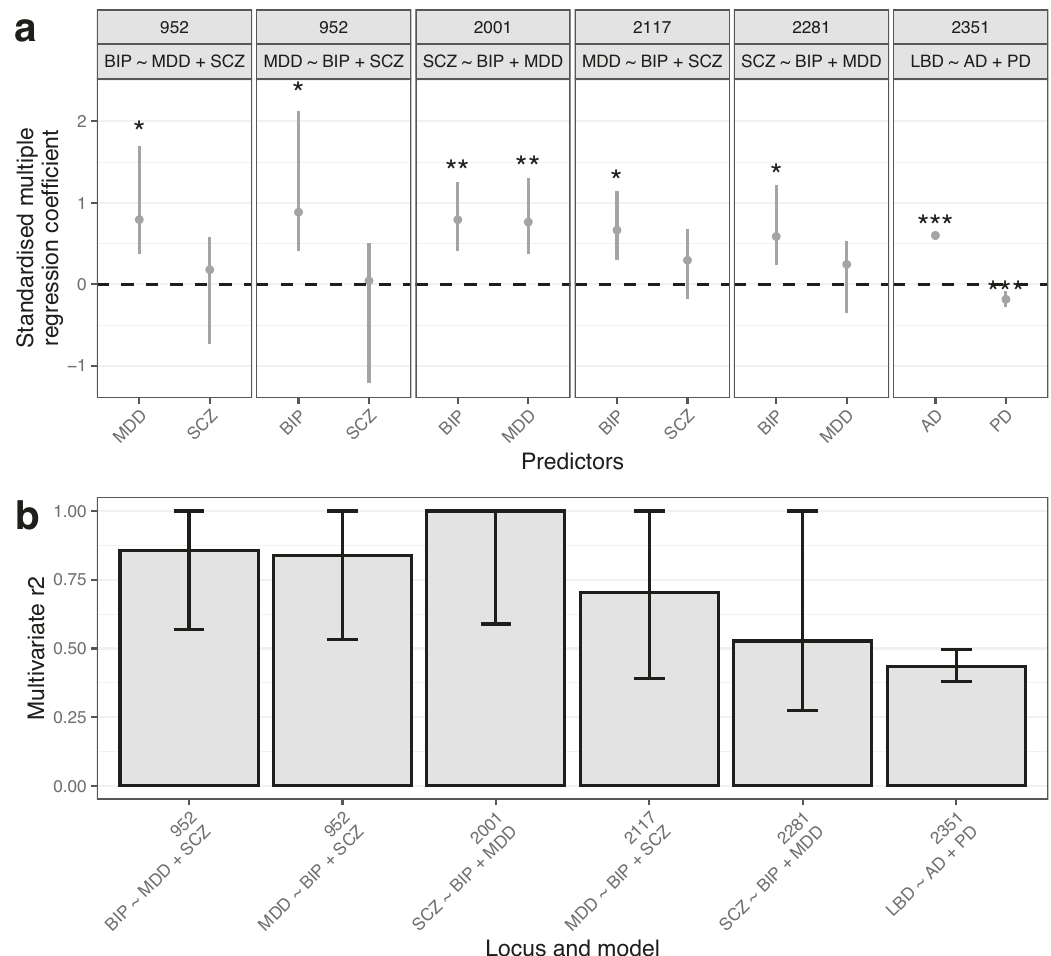
Fig. 3 Multiple regression across LD blocks with multiple trait pair correlations. For both plots, only those multiple regression models with at least one signi fi cant predictor ( p < 0.05) are shown (for models where all predictors were non-signi fi cant, see Supplementary Fig. 4). a Plots of standardised coef fi cients for each predictor in multiple regression models across each LD block, with whiskers spanning the 95% con fi dence interval for the coef fi cients. Panels are labelled by the LD block identi fi er and the regression model. b Multivariate r 2 for each LD block and model, where multivariate r 2 represents the proportion of variance in genetic signal for the outcome trait explained by all predictor traits simultaneously. Whiskers span the 95% con fi dence interval for the r 2 . *** p < 0.001; ** p < 0.01; * p < 0.05. Coordinates for LD blocks (in the format chromosome:start-end, GRCh37): 952, chr6:27,261,036-28,666,364; 2001, chr14:71,140,427-72,665,319; 2117, chr16:12,793,150- 13,893,407; 2281, chr18:52,512,524-53,762,996; 2351, interest to at least one of the disease traits implicated by local r g Incorporation of gene expression traits to facilitate functional interpretation of disease trait correlations analyses. From these LD blocks of interest, we de fi ned genic regions (gene start and end coordinates ± 100 kb) for all over- To dissect whether regulation of gene expression might underlie lapping protein-coding, antisense or lincRNA genes ( n = 92). local r g s between disease traits, we performed local r g analyses using expression quantitative trait loci (eQTLs) from eQTLGen 42 and PsychENCODE 43 , which represent large human blood and brain expression datasets, respectively (Table 1). We used LAVA to study relationships between gene expression and disease traits on account of its ability to model the uncertainty in eQTL effect estimates (unlike the commonly used TWAS framework, which as a result, has an increased type 1 error rate 44 ). In addition, where three-way relationships were observed between 2 disease traits and an eQTL, we computed partial correlations to determine whether correlations between disease traits could be explained by the eQTL. We restricted analyses to the 5 LD blocks highlighted in Fig. 2 (LD block 681, chr4:90,236,972-91,309,863; LD block 1273,